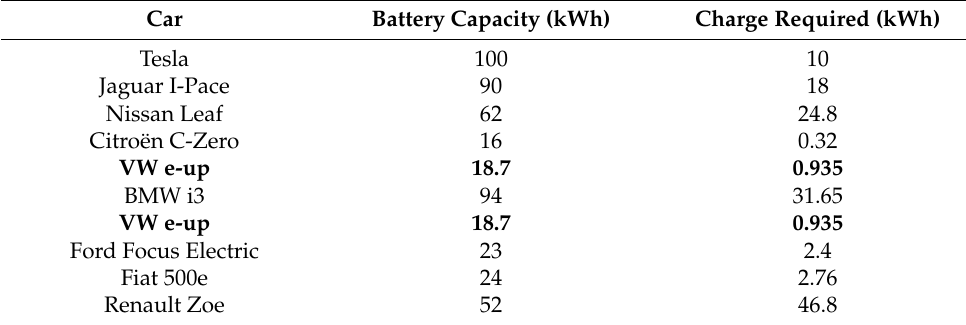
Table 8. Two identical VW e-up requesting the same amount of